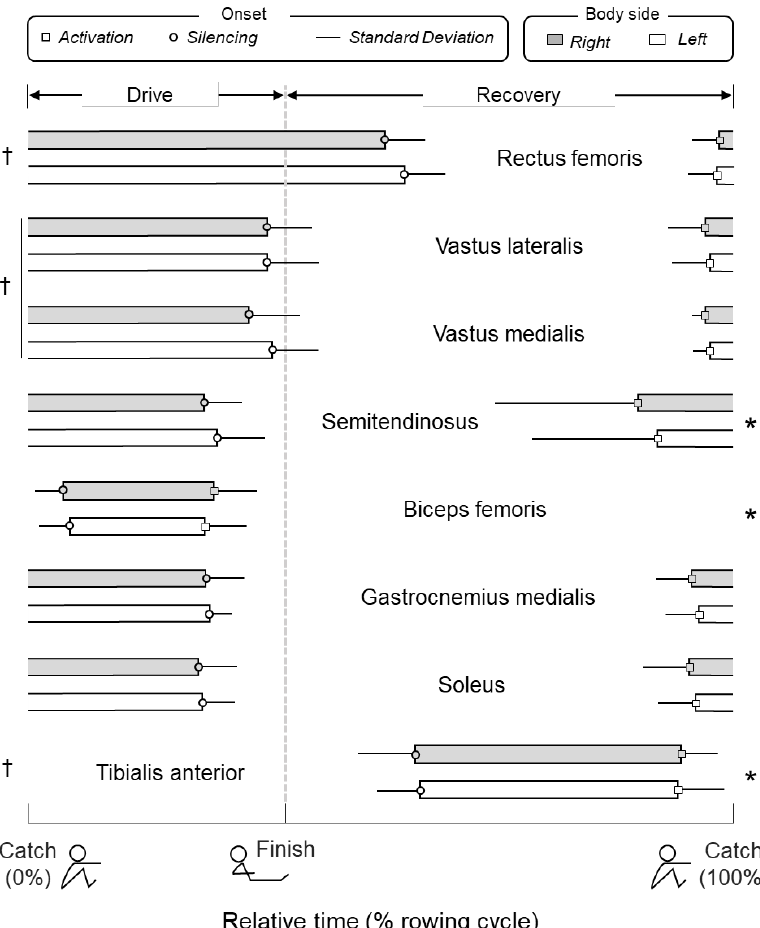
Figure 3. Mean values for the onset of activation (squares) and silencing (circles) are shown for the eight muscles tested in the left (white bars) and right (grey bars) sides. Horizontal lines denote the standard deviation of onset values. * and † respectively indicate the onset values of activation and silencing for the corresponding muscle were different from all other muscles ( P < 0.05 for all cases), regardless of the body side.